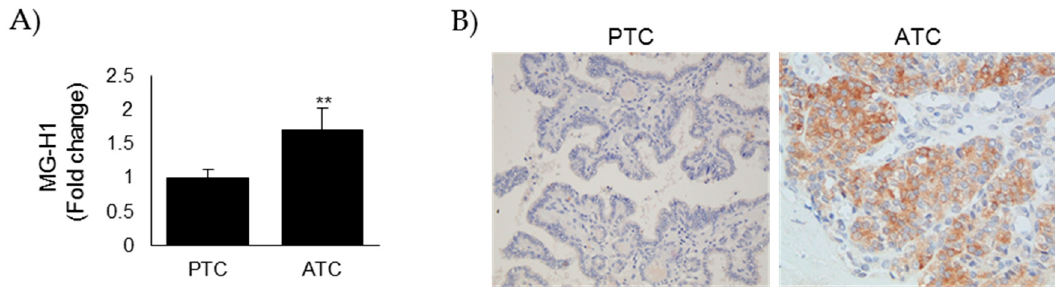
Figure 1. MG-derived hydroimidazolone (MG-H1) adducts are accumulated in anaplastic thyroid cancer (ATC) tissues when compared with papillary thyroid cancer (PTC) ones. ( A ) Intracellular levels of MG-H1, measured by a specific ELISA kit, in protein extracts from PTC ( n = 5, #6–10) and ATC ( n = 5, #1–5) tissues. Results are expressed as mean ± SD. ** p < 0.01; ( B ) Representative immunohistochemical staining of MG-H1 on PTC ( n = 5, #16–20) and ATC ( n = 5, #11–15) tissues (200 × magnification).